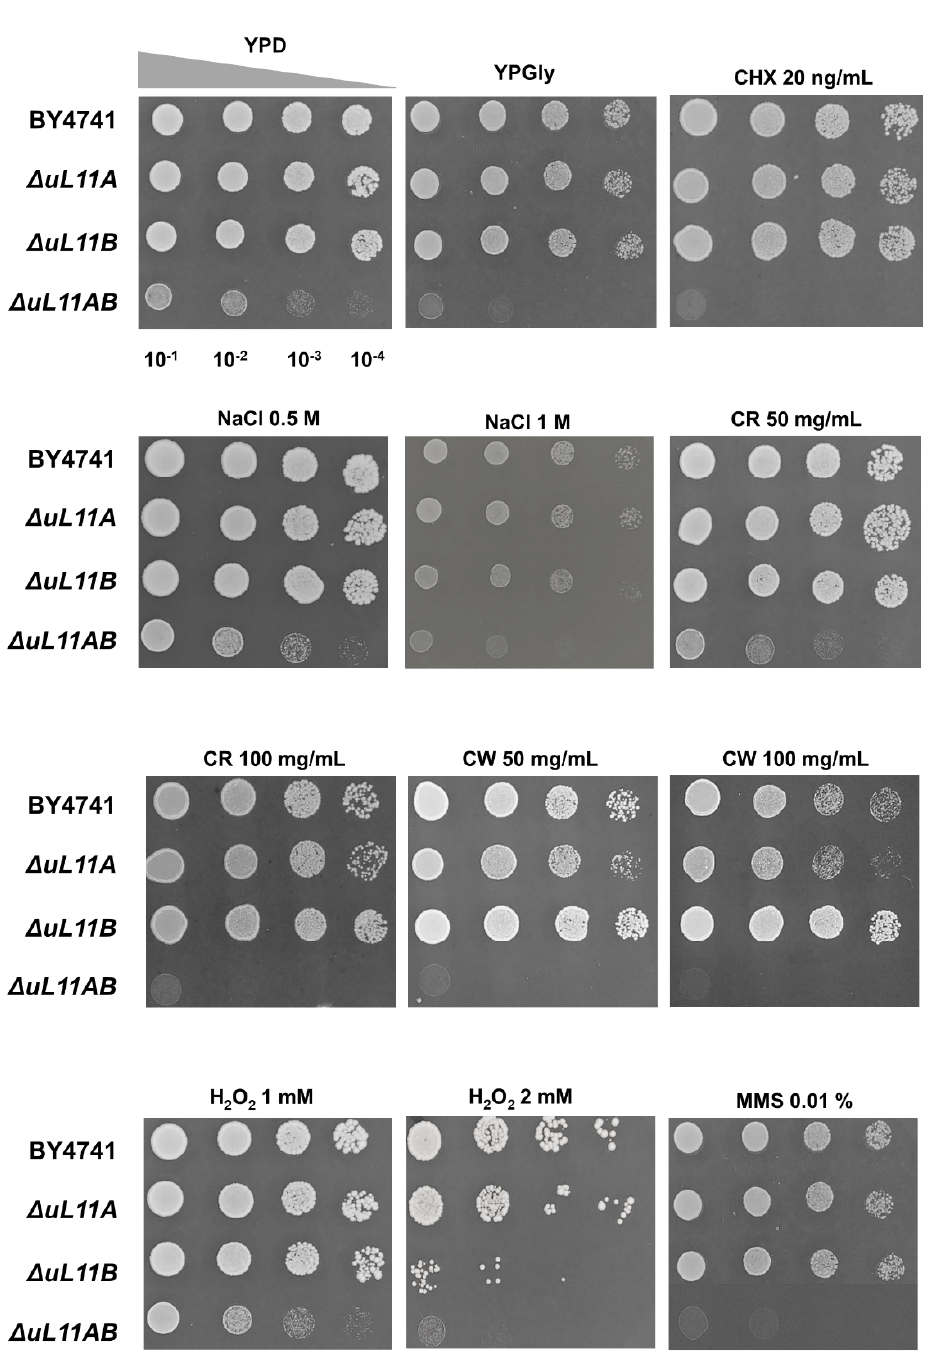
Figure 2. Phenotype screening analysis of yeast mutant strains exposed to di ff erent environmental conditions. Yeast strains were grown in YPD medium, spotted onto YPD plates containing the indicated amounts of cycloheximide (CHX), sodium chloride (NaCl), Congo red (CR), calcofluor white (CW), hydrogen peroxide (H 2 O 2 ), and methyl methanesulfonate (MMS) and incubated at 28 ◦ C. Growth on YPD agar plates was treated as a control. Representative results from two independent experiments are shown.